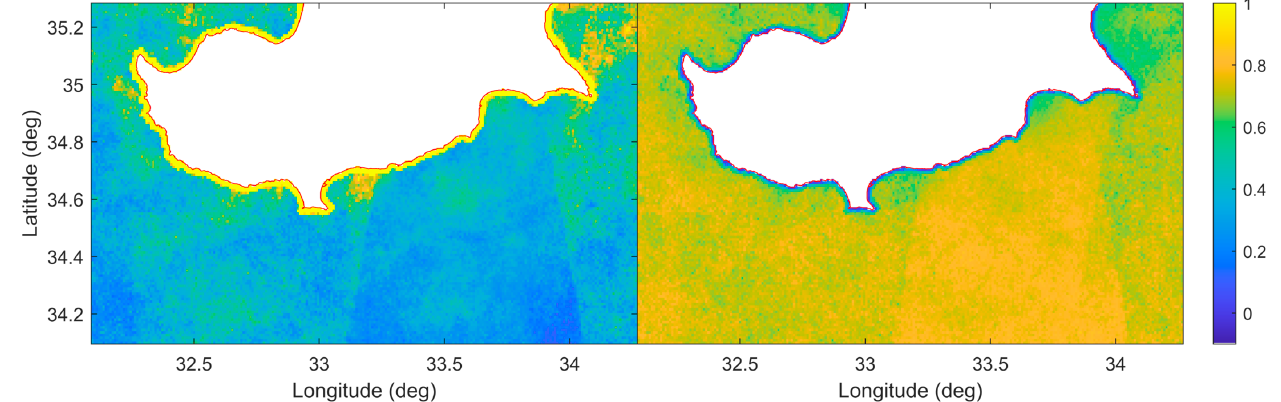
Figure 9. Kullback–Leibler divergence ( left ) and Perkins skill score ( right ) used to quantify the divergence and similarity of the reference and simulation distributions per grid cell, respectively.